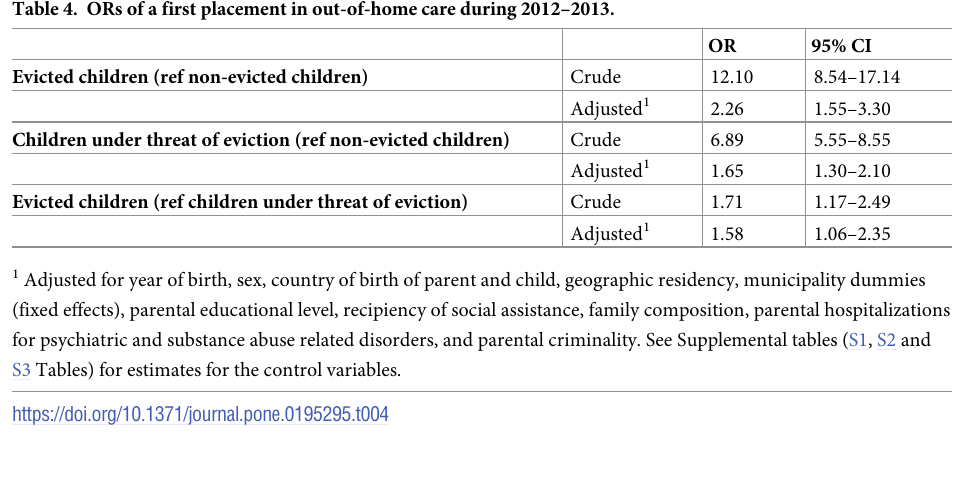
Table 4. ORs of a first placement in out-of-home care during 2012–2013. Evicted children (ref non-evicted